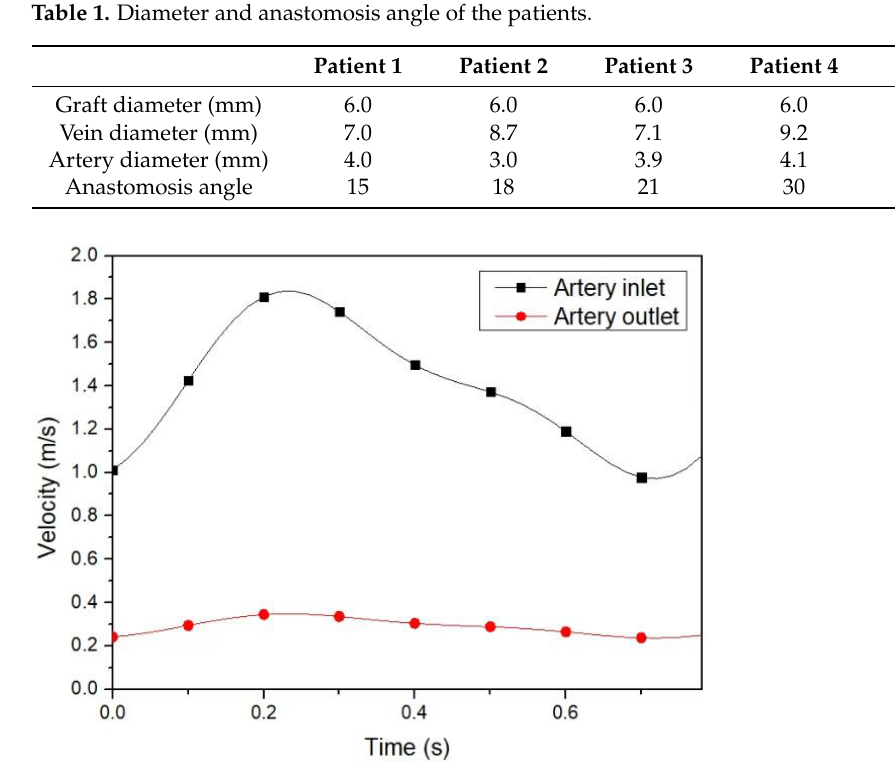
Figure 4. Velocity profile throughout the cardiac cycle at the graft and